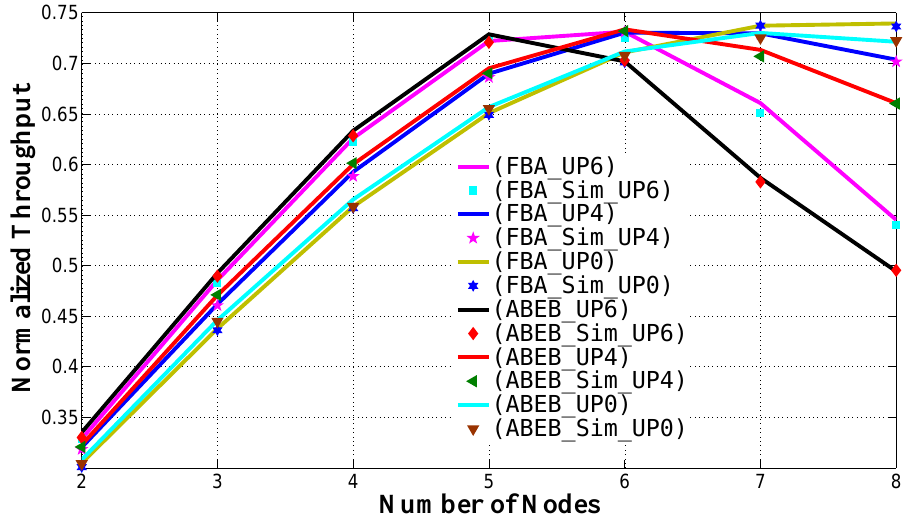
Figure 10. Normalized system throughput in the homogeneous case for different backoff